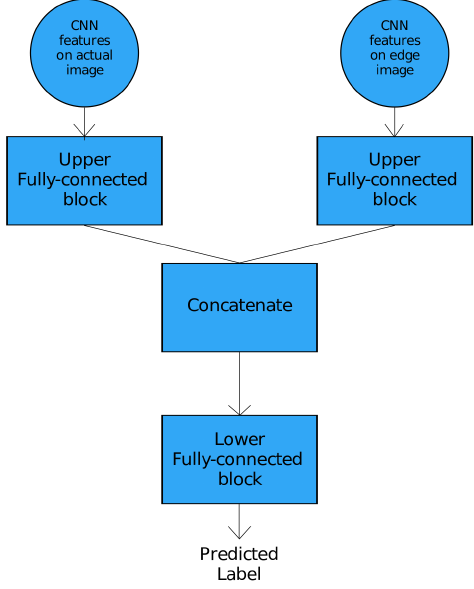
Figure 6. Illustration for hybrid ANN.